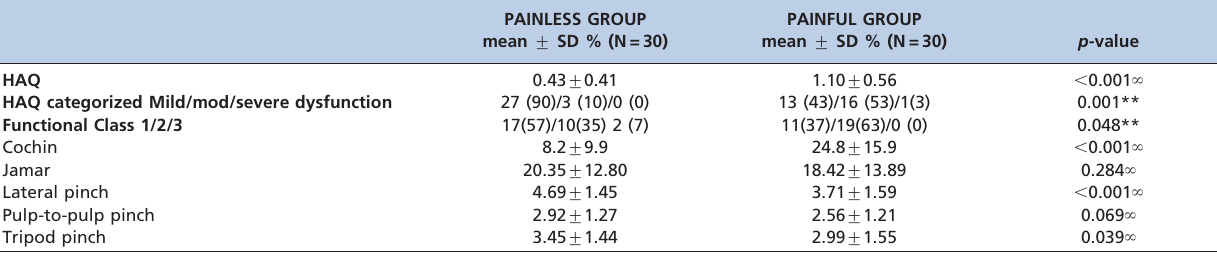
Table 4 - Current functional assessment of the